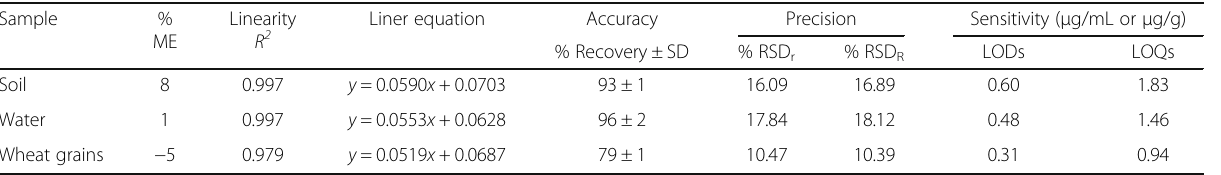
Table 9 Investigation of Validity of the Method